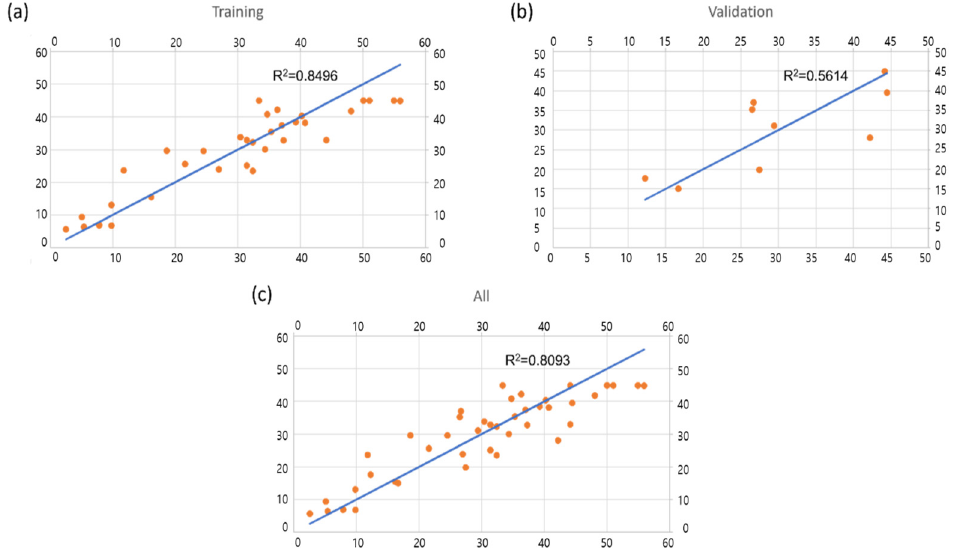
Figure 5. Correlation analysis for regression models for shear strength of NCA ( a ) training, ( b ) validation, and ( c ) all.